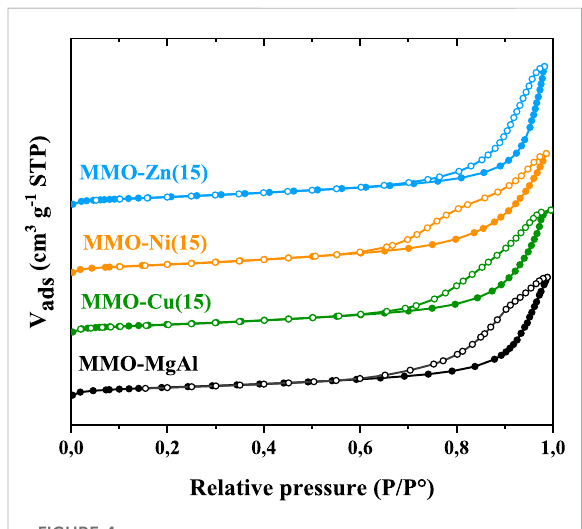
FIGURE 4 N 2 adsorption-desorption isotherms of the mixed oxides.